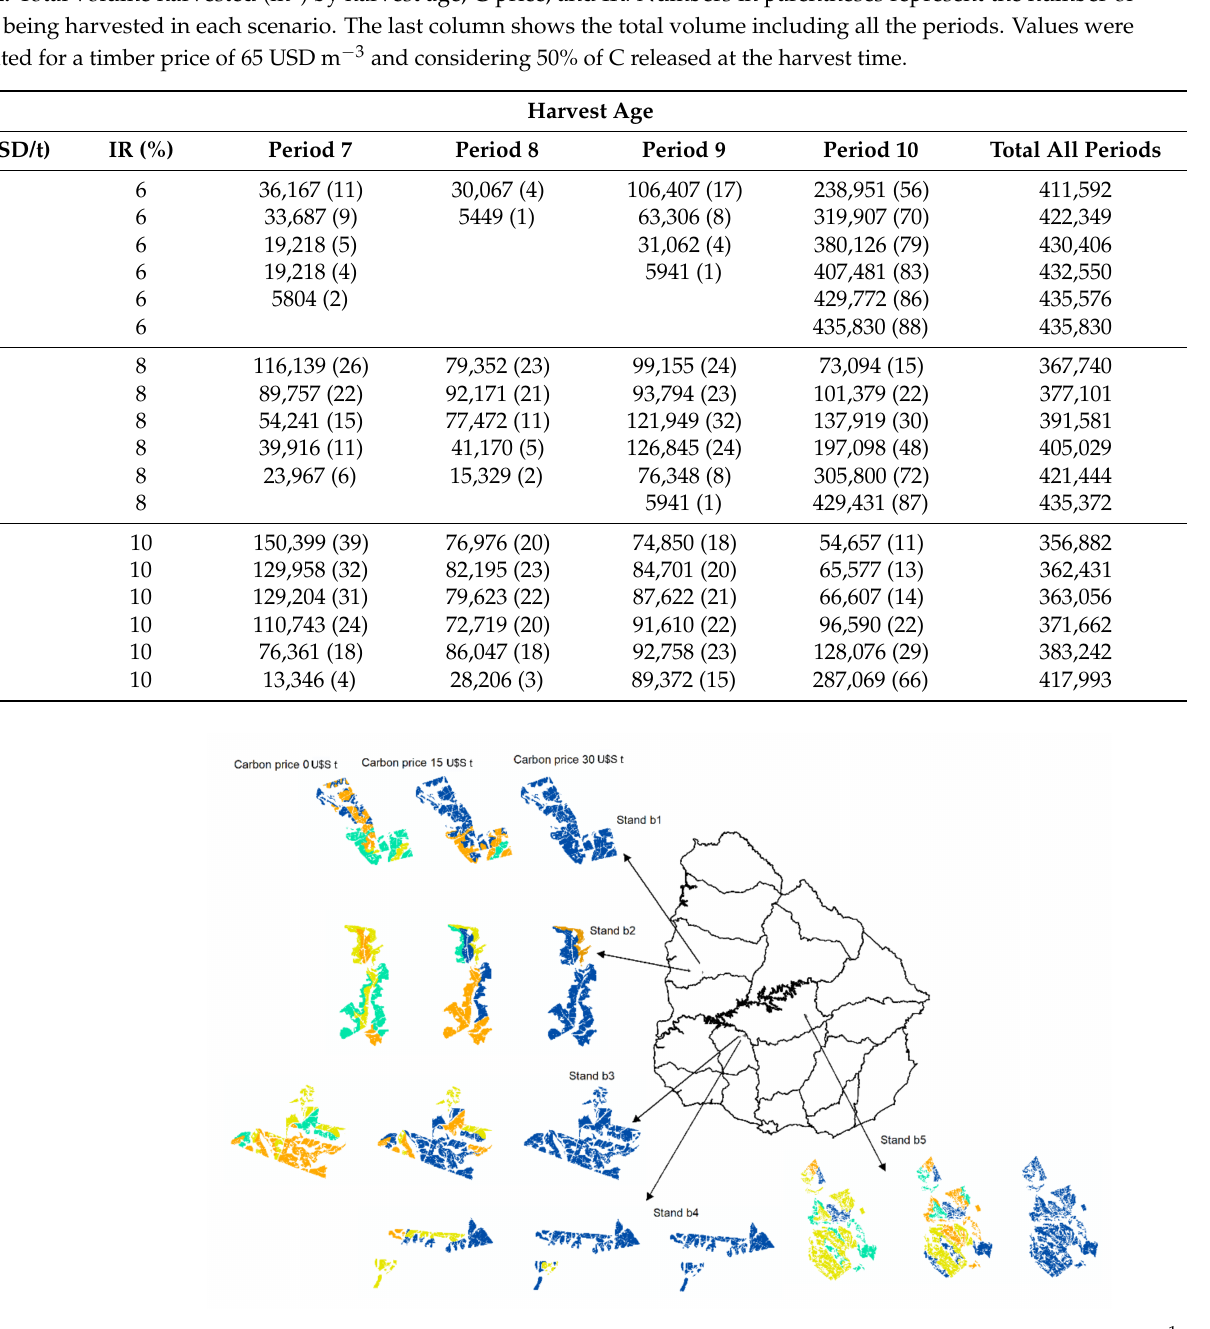
Figure 3. Harvest age and harvest spatial distribution of the stands by C price (0, 15, and 30 USD t − 1 ). The harvest ages are represented in yellow (period 7), green (period 8), orange (period 9), and blue (period